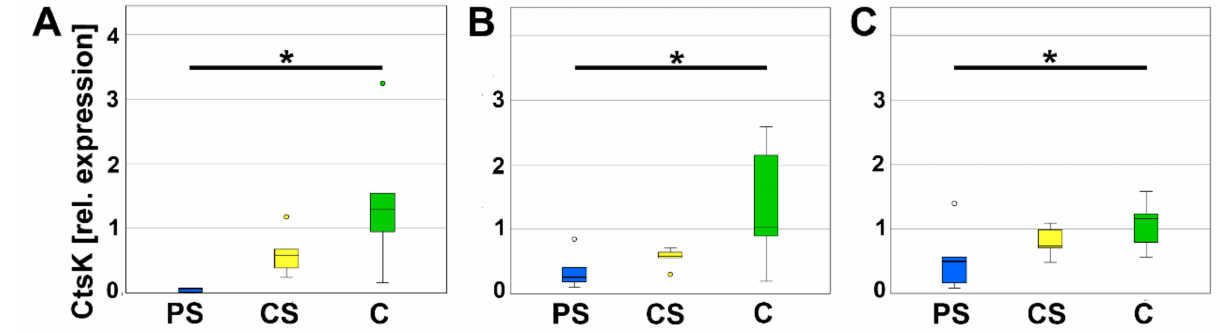
Figure 7. Relative expression of CtsK after 4 ( A ), 8 ( B ), and 12 days ( C ). * indicates a statistically significant likelihood of p ≤ 0.05. Circles denote outliers.